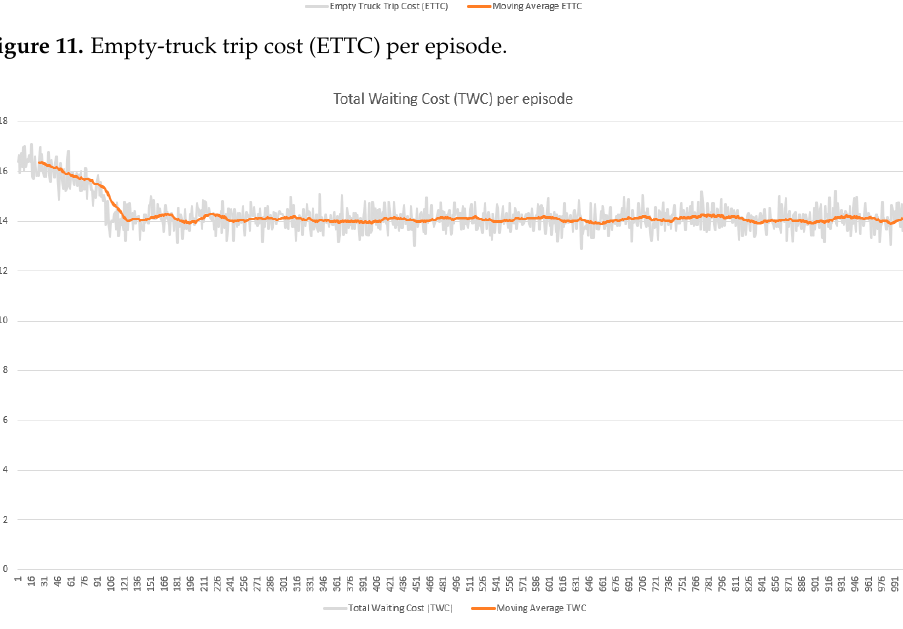
Table 8. Performance parameter